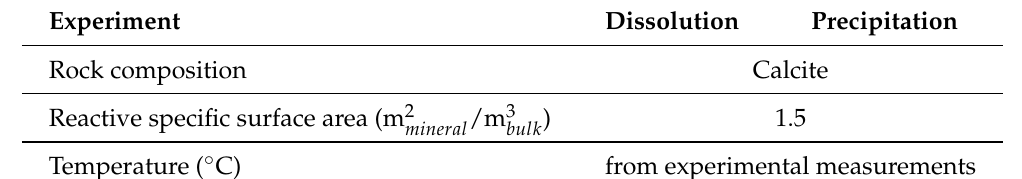
Table 3. Input parameters used for the CrunchFlow simulations. Input pore water concentration values come from the outlet pore water chemical analyses, and inlet solution concentration values come from S1 and S2